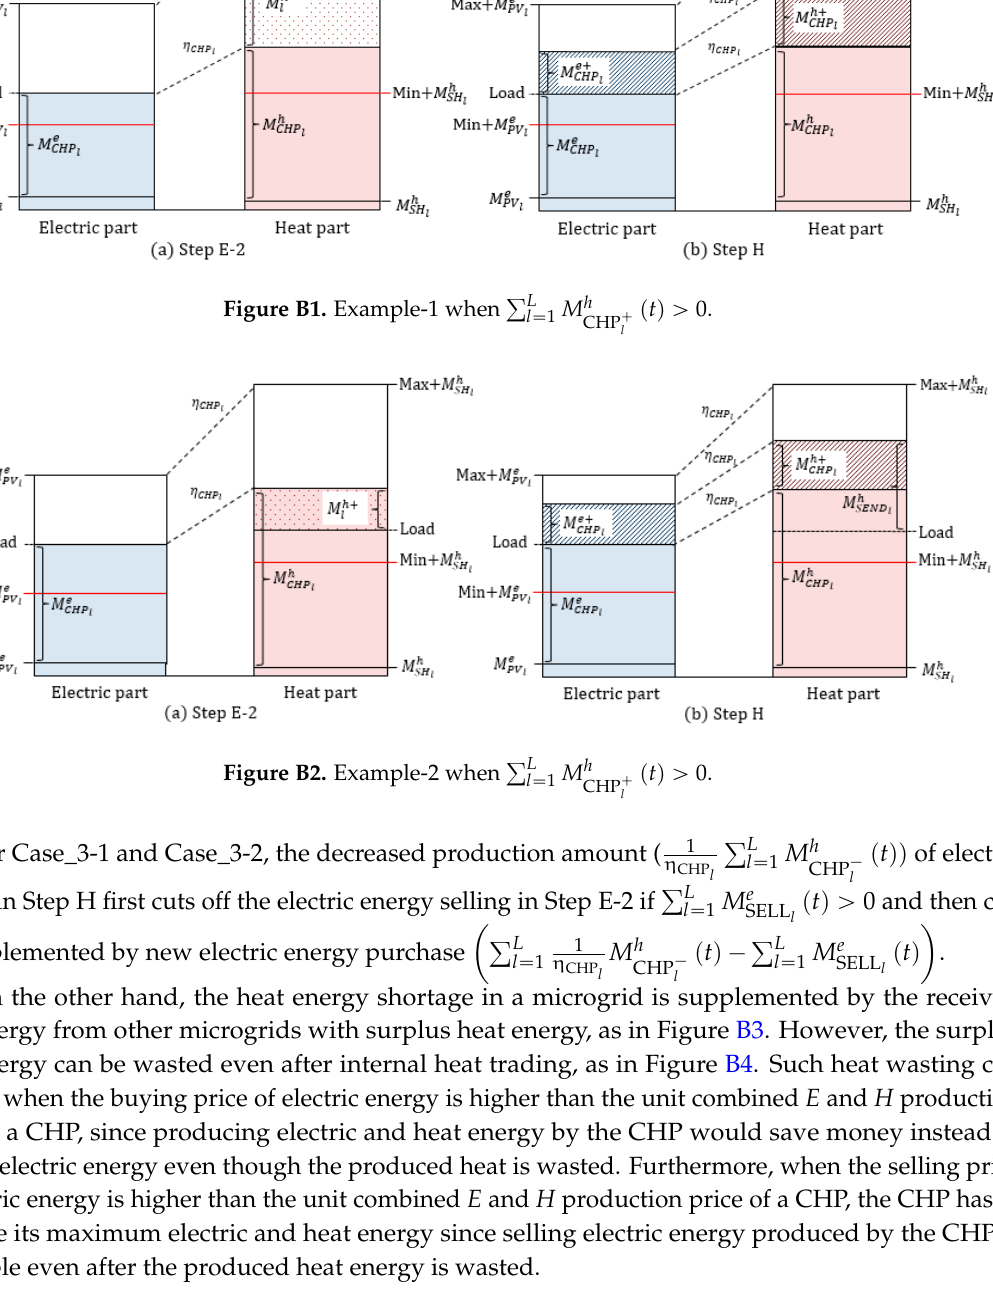
Figure B3. Example ‐ 3 when ∑